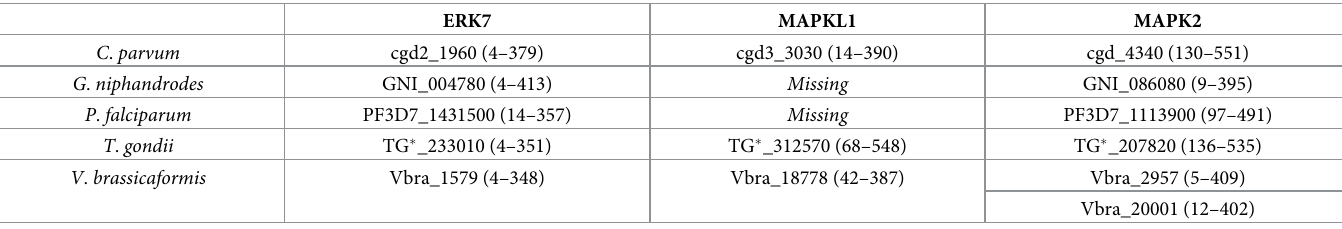
Table 1. Apicomplexan MAPK gene